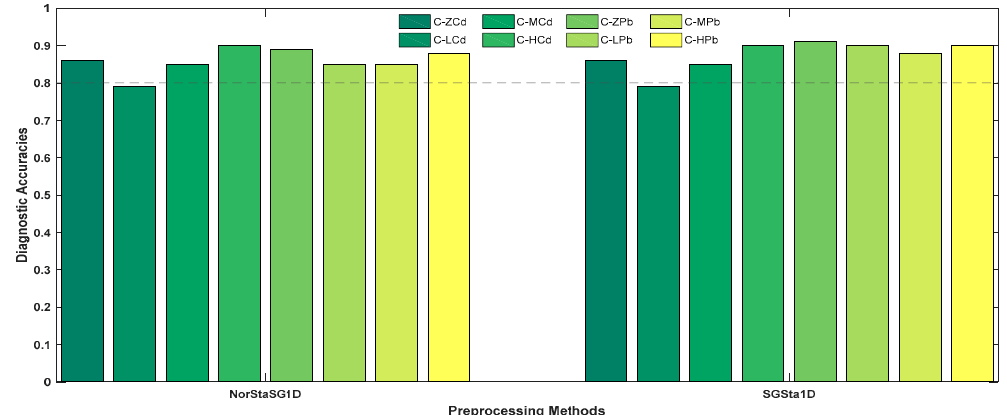
Figure 6. Diagnostic accuracies of different types and stress levels with NorStaSG1D (Left) and SGSta1D (Right). (NorStaSG1D is a pre-processing method with normalization, standardization, Savitzky-Golay smoothing, and 1st-Derivative, successively, while SGSta1D is a pre-processing method with Savitzky-Golay smoothing, standardization, and 1st-Derivative, successively).